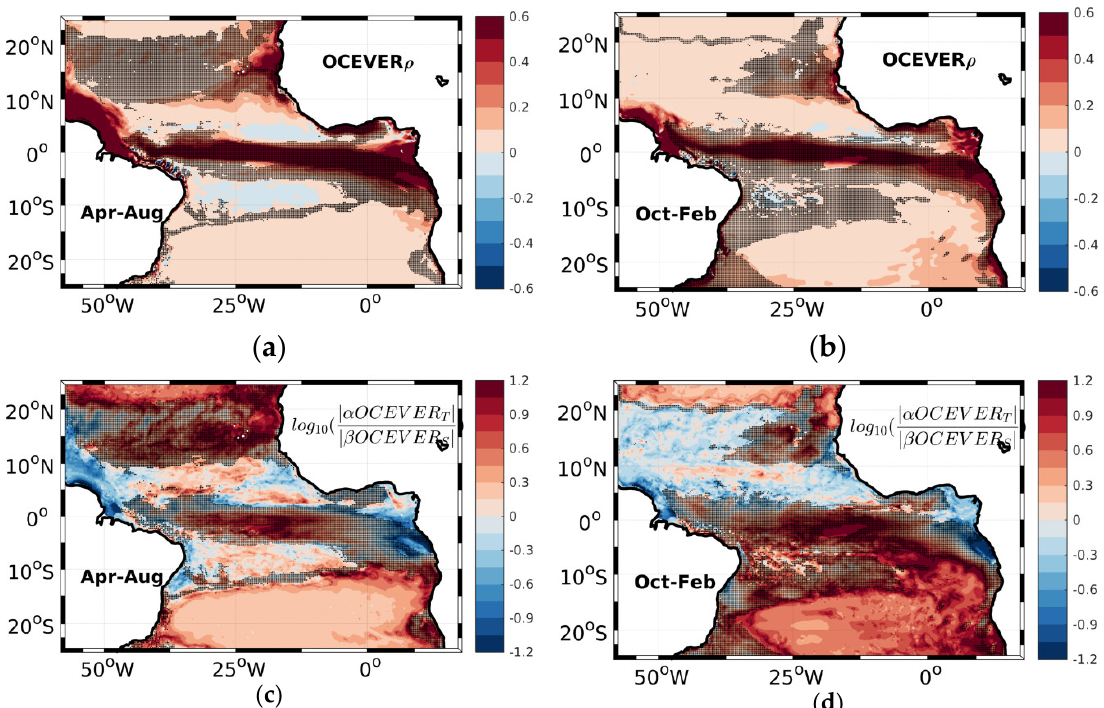
Figure 6. Similar to Figure 5, but for the contribution of total vertical oceanic physical processes to mixed layer density variations.